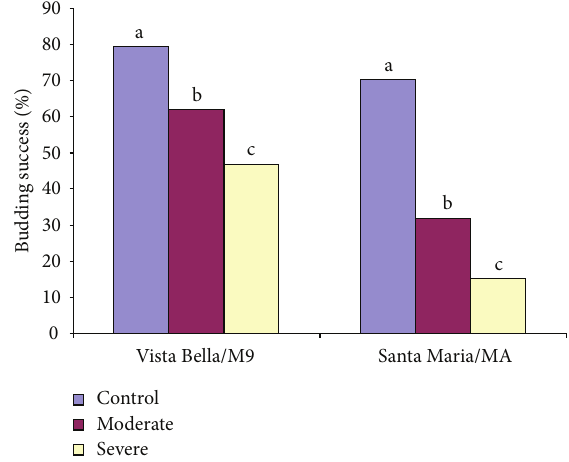
Figure 1: Budding success of Vista Bella/M9 and Santa Maria/MA grown under before and after budding water stress conditions. (Dif- ferent letters shown in bars in each rootstock show the significant differences in 1% LSD